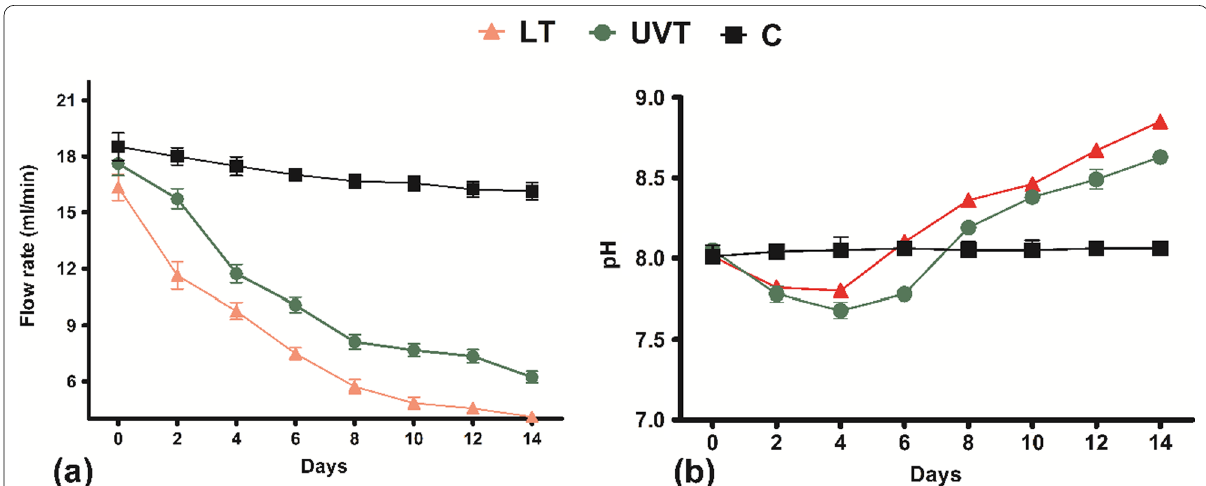
Fig. 2 Estimation of a the flow rate of the calcifying solution b pH of the effluent solution injected through sand columns till 14 days